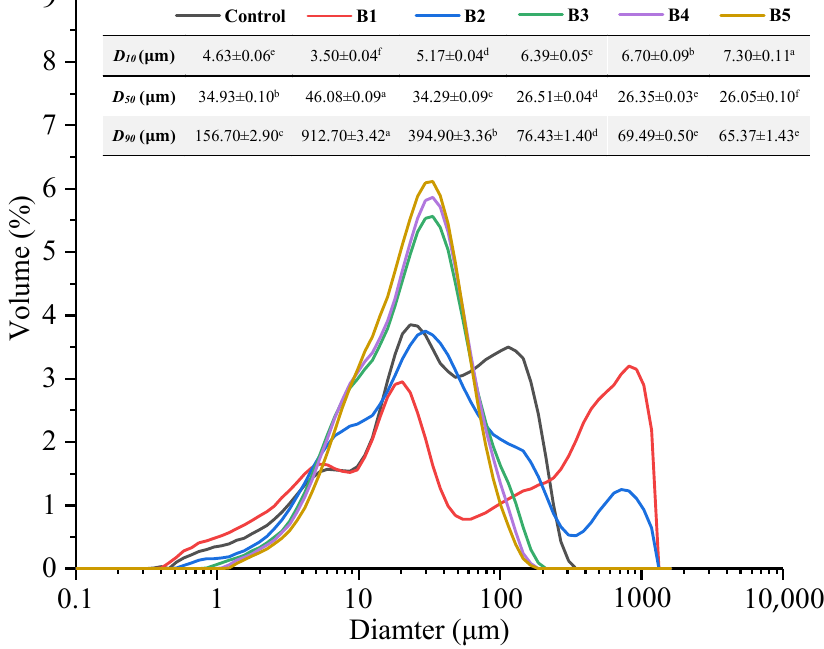
Figure 1. Particle size distribution of wheat bran. B1, B2, B3, B4, and B5 are the wheat brans with different particle sizes. D 10 , D 50 , and D 90 are mean particle sizes at 10%, 50%, and 90% of the volume distribution, respectively. Refined wheat flour served as a control group. Different letters on each row indicate significantly different values ( p < 0.05).